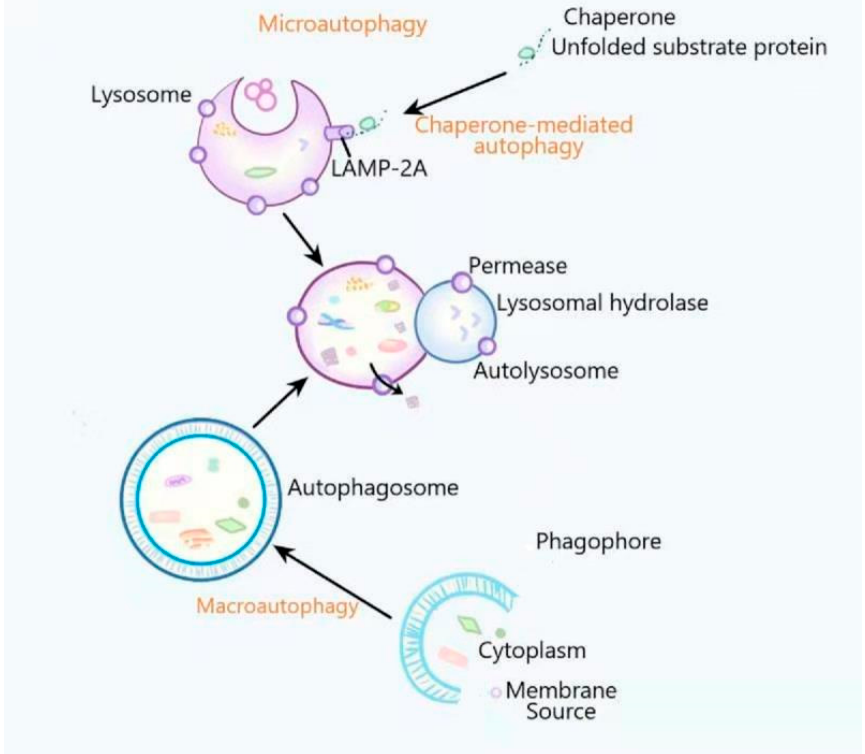
Figure 1. The general process of macroautophagy, microautophagy and chaperone-mediated au- tophagy. In the process of macroautophagy, the content is wrapped by a bilayer membrane structure to form an autophagosome and then fuses with lysosomes for degradation. Microautophagy refers to the process by which the lysosomal membranes directly invaginate and then encapsulate the cell contents. In the process of chaperone-mediated autophagy, the cytosolic proteins are trans- ported to the lysosomal chamber after binding to molecular chaperones and then are digested by lysosomal enzymes.